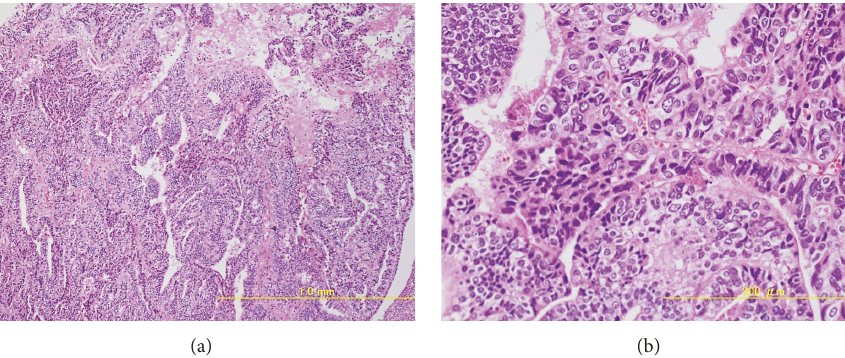
Figure 3: Histopathological findings. The diagnosis was urethral adenocarcinoma with various characteristics. (a) Hematoxylin and eosin stain, × 40. (b) Hematoxylin and eosin stain, × 200.